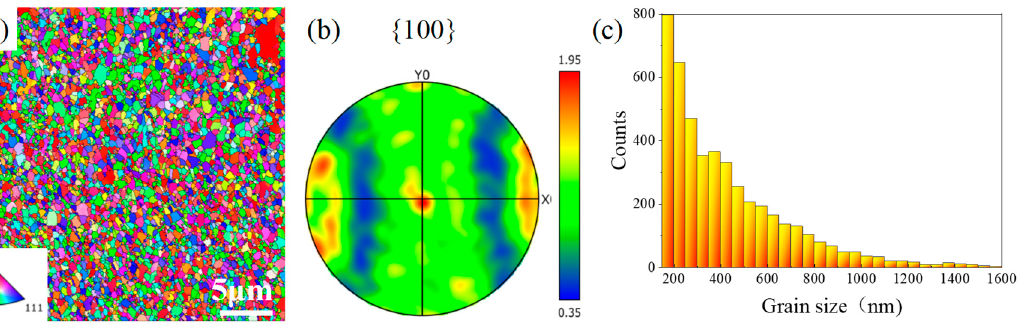
Figure 3. EBSD information of electrodeposition Ni lattice: ( a ) grain orientation imaging figure; ( b ) pole figure image; ( c ) grain size distribution.